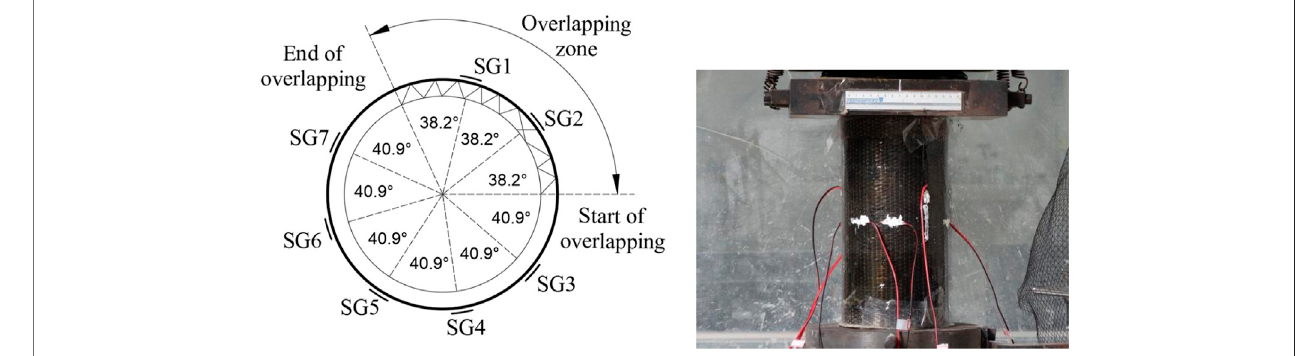
FIGURE 1 | Arrangement of strain gauges.